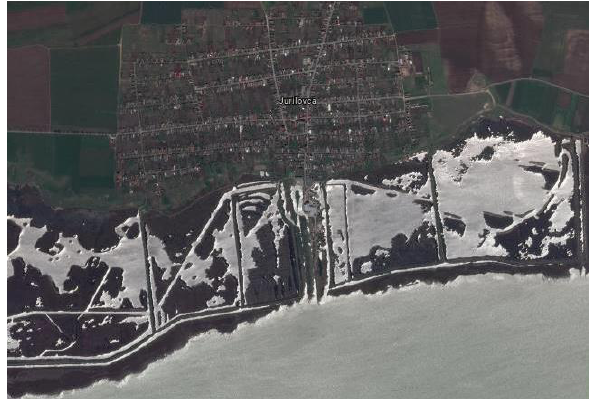
Figure 5. Jurilovca village seen from Google